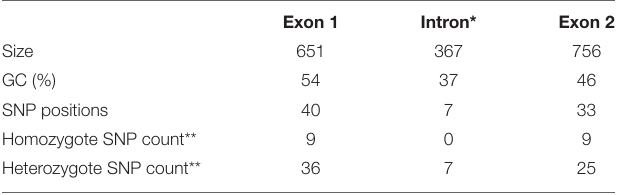
TABLE 2 | Summary of EMS-induced mutations in UGT74S1 gene of a mutagenized flax